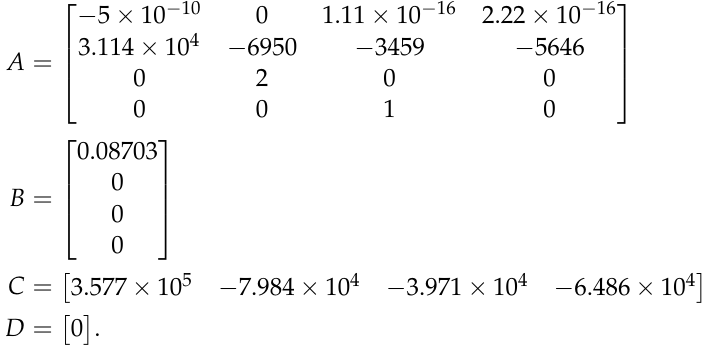
Table 4 lists the optimum parameters for the proposed fixed-structure H ∞ synthesis.